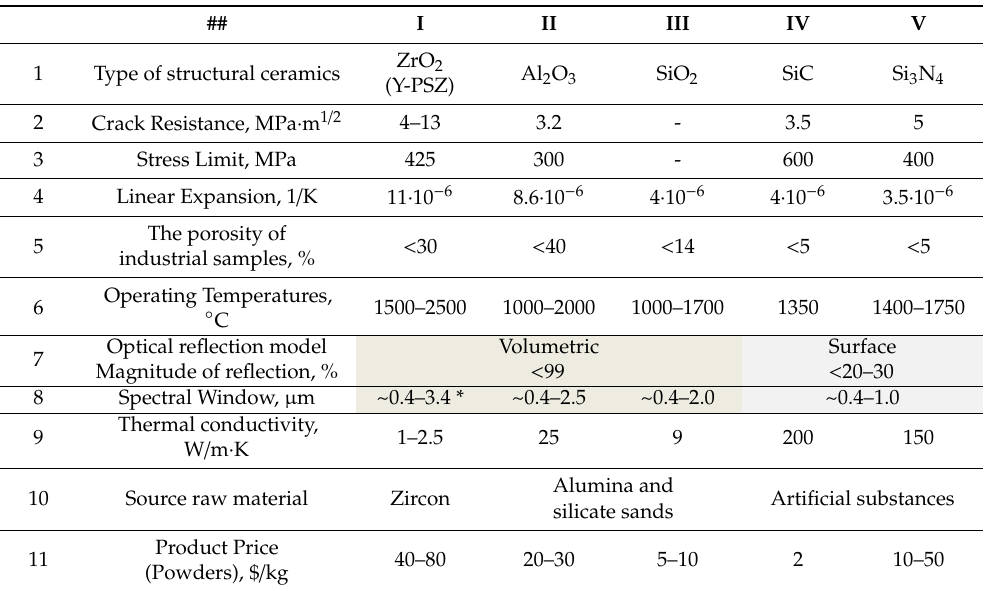
Table 1. Physical, technical characteristics and commercial parameters of industrial ceramic